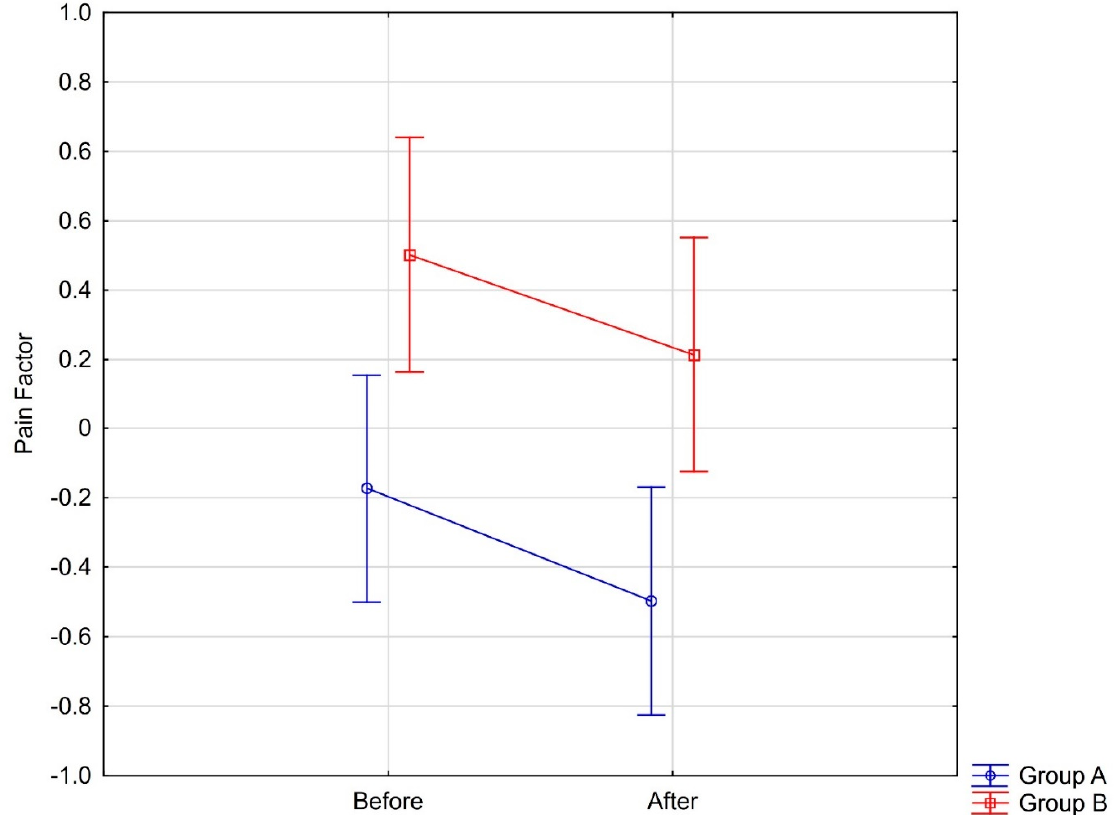
Figure 7. Pain factor changes among groups during experiment.